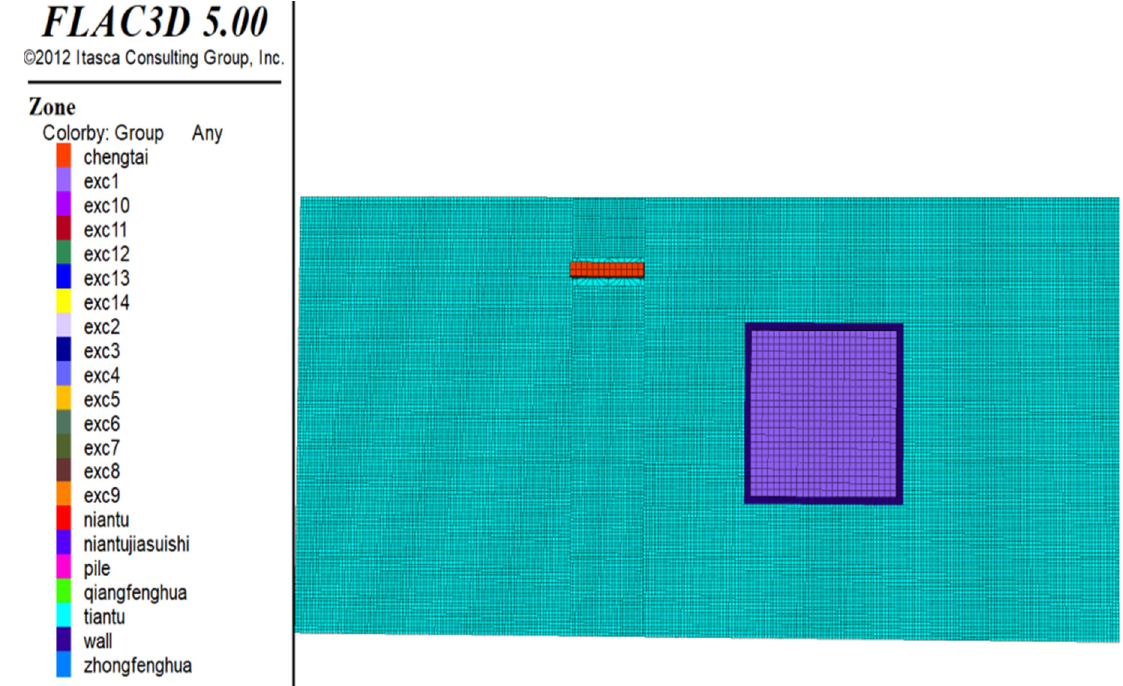
Figure 10. FLAC3D